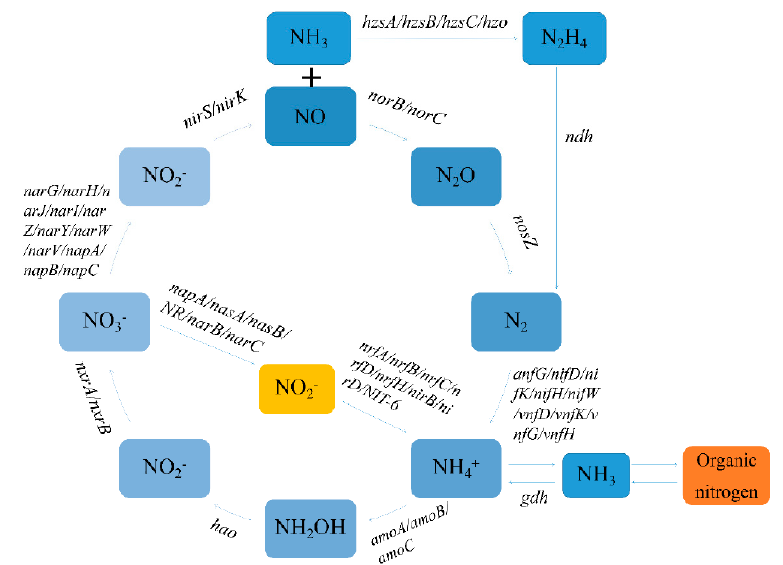
Figure 1. The nitrogen cycle and involved key functional